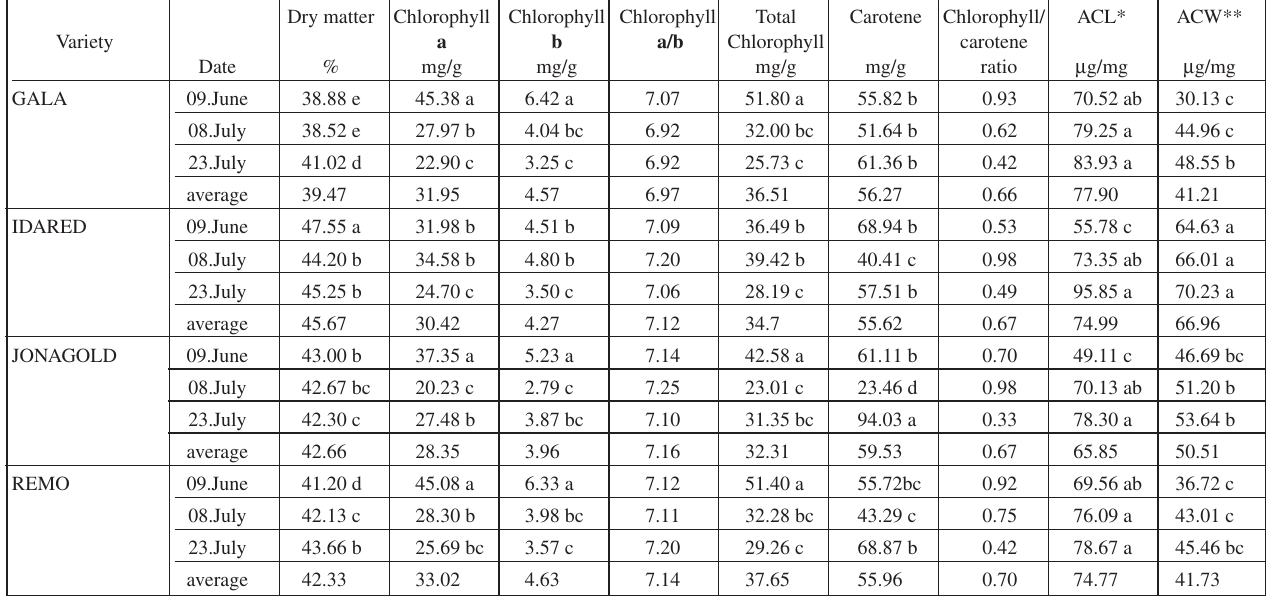
Table 5. Changes in the chlorophyll and antioxidant content in the leaves of apple tree during fruit development in Debrecen-Pallag Dry matter Chlorophyll Chlorophyll Chlorophyll Total Carotene Chlorophyll/